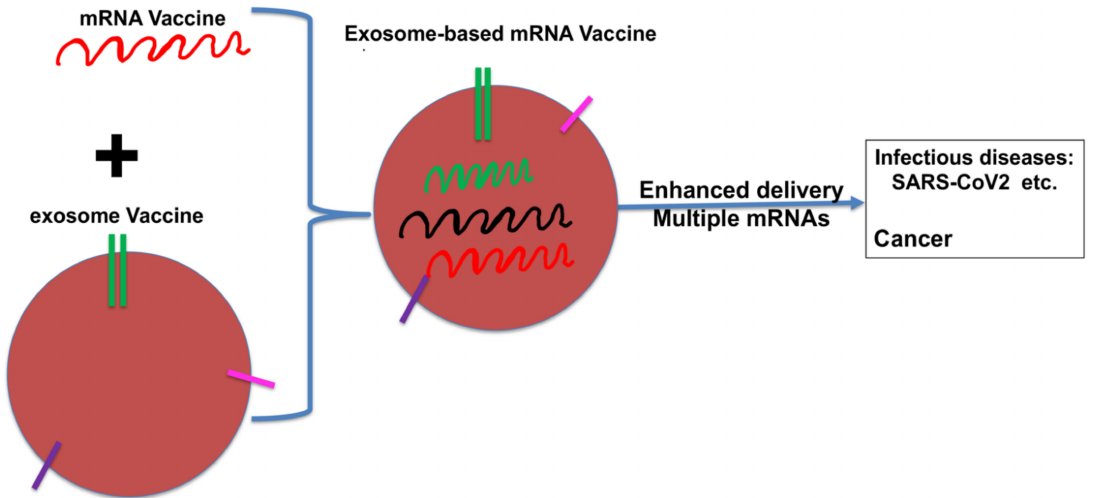
Figure 3. Exosome-based mRNA vaccines for immunotherapy. Combining exosome and mRNA vaccines might represent a promising strategy to further improve mRNA-based vaccines again infectious diseases and cancer: receptors on exosomes could enhance the targeted delivery of mRNAs, and multiple mRNAs could be efficiently